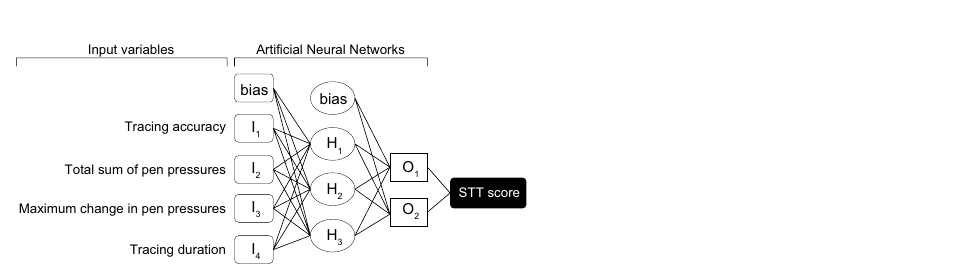
Figure 4. STT score yielded by the system using three layer perceptron ANN. When the 4 variables calculated from STT results were entered, the system yielded a “probability of being likely to be a healthy individual (STT score)”. Hyperbolic tangent function was chosen as activation function of Hidden